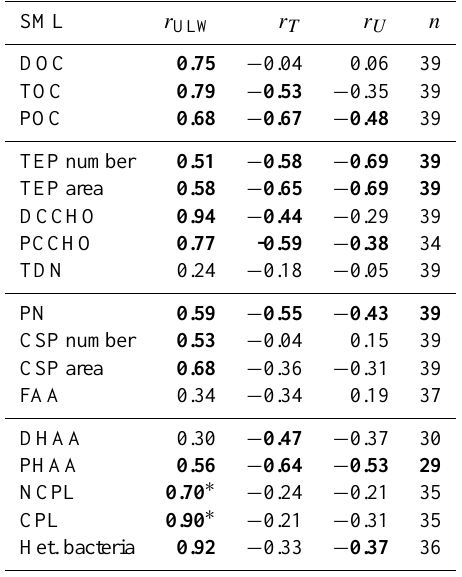
Table 3. Correlation coefficients ( r) between concentrations of var- ious organic components in the SML and their concentration in the underlying seawater (ULW), temperature ( T , ◦ C), and wind speed ( U , ms − 1 ) at the time of sampling. Correlations yielding a signifi- cance level of p <0.01 are marked bold. For abbreviations see text. SML r ULW r T r U